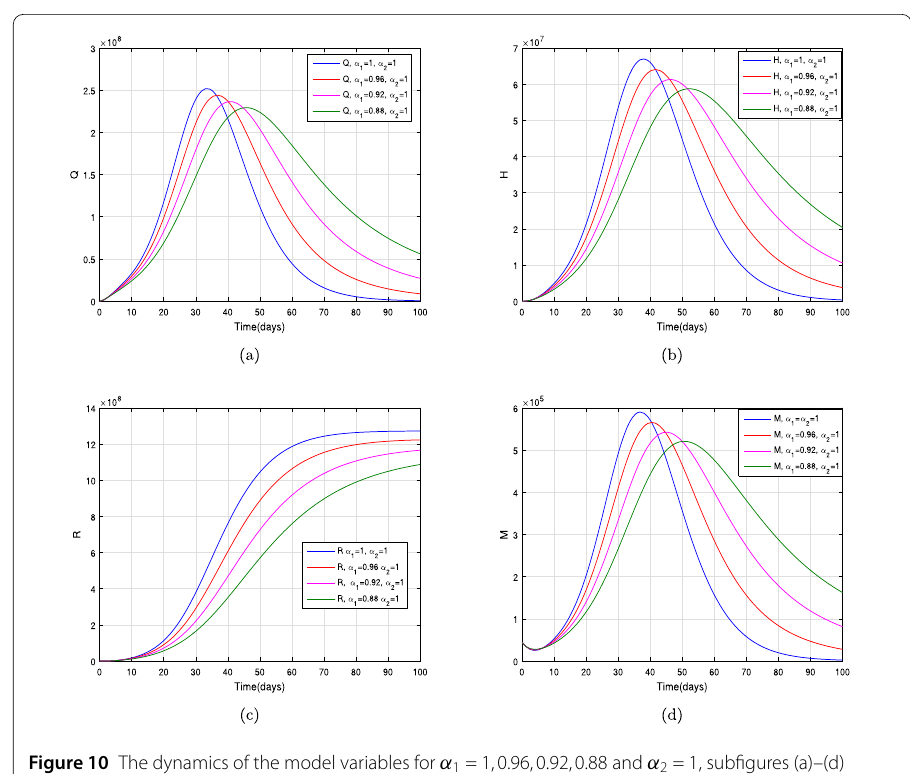
Figure 10 The dynamics of the model variables for α 1 = 1,0.96,0.92,0.88 and α 2 = 1, subfigures (a)–(d) respectively represent the quarantined, hospitalized, recovered, and contaminated environment